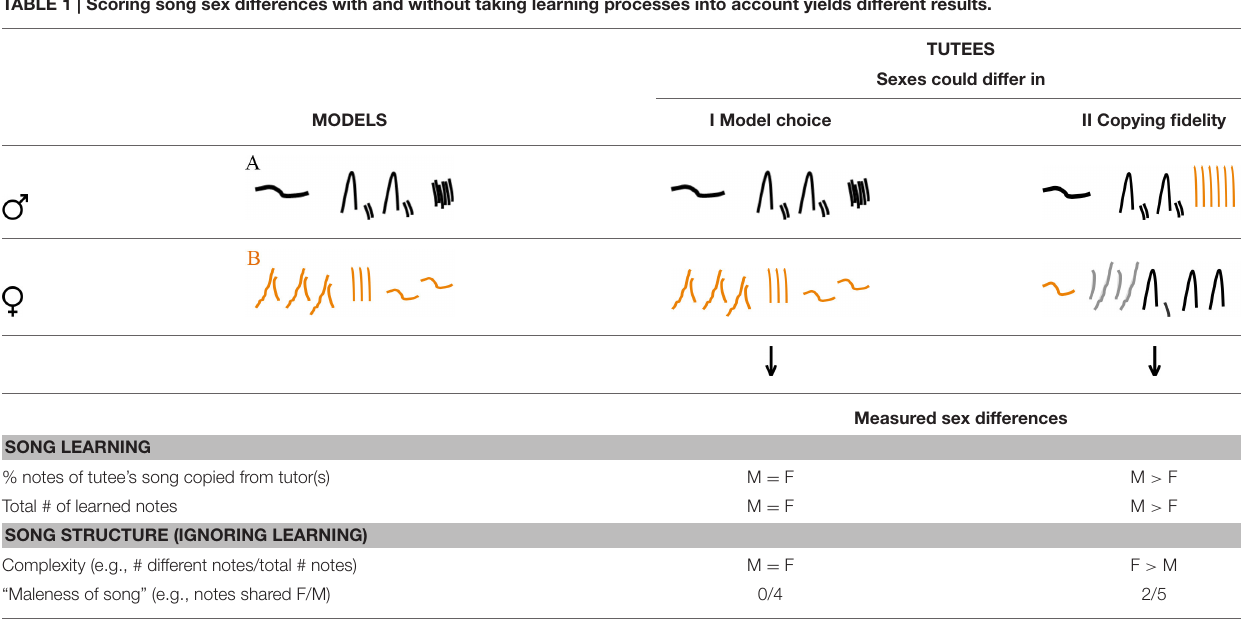
TABLE 1 | Scoring song sex differences with and without taking learning processes into account yields different